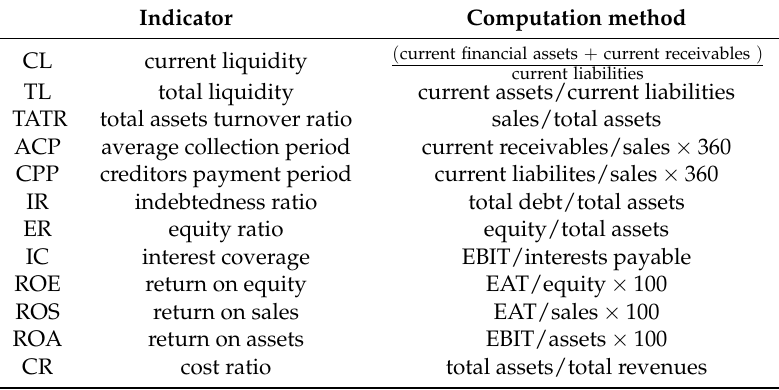
Table 1. Method used to compute selected financial indicators.